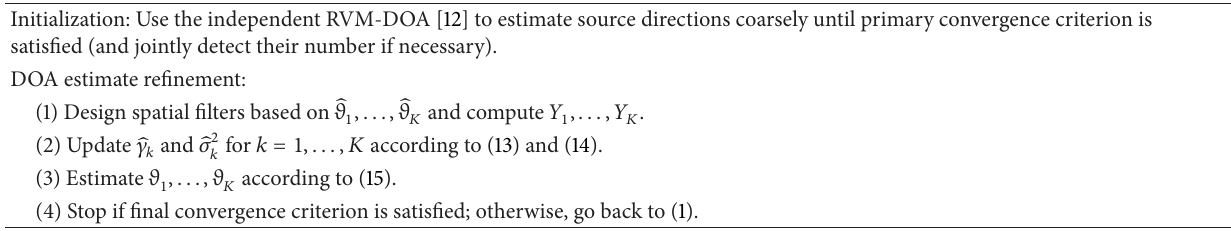
Table 1: Outline of SF